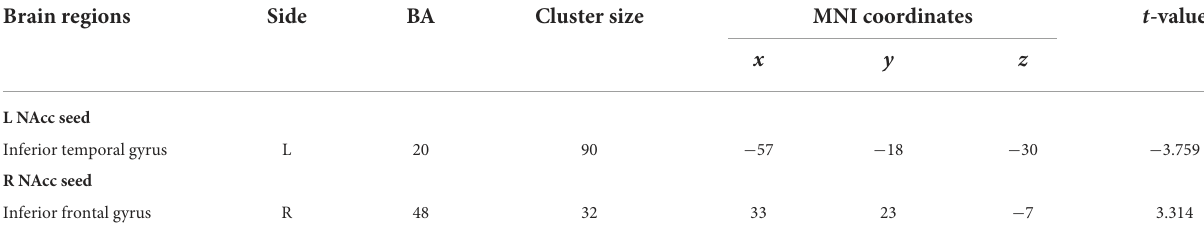
TABLE 4 Functional connectivity differences of the nucleus accumbens seeds between patients after treatment and before treatment (after treatment > before treatment).